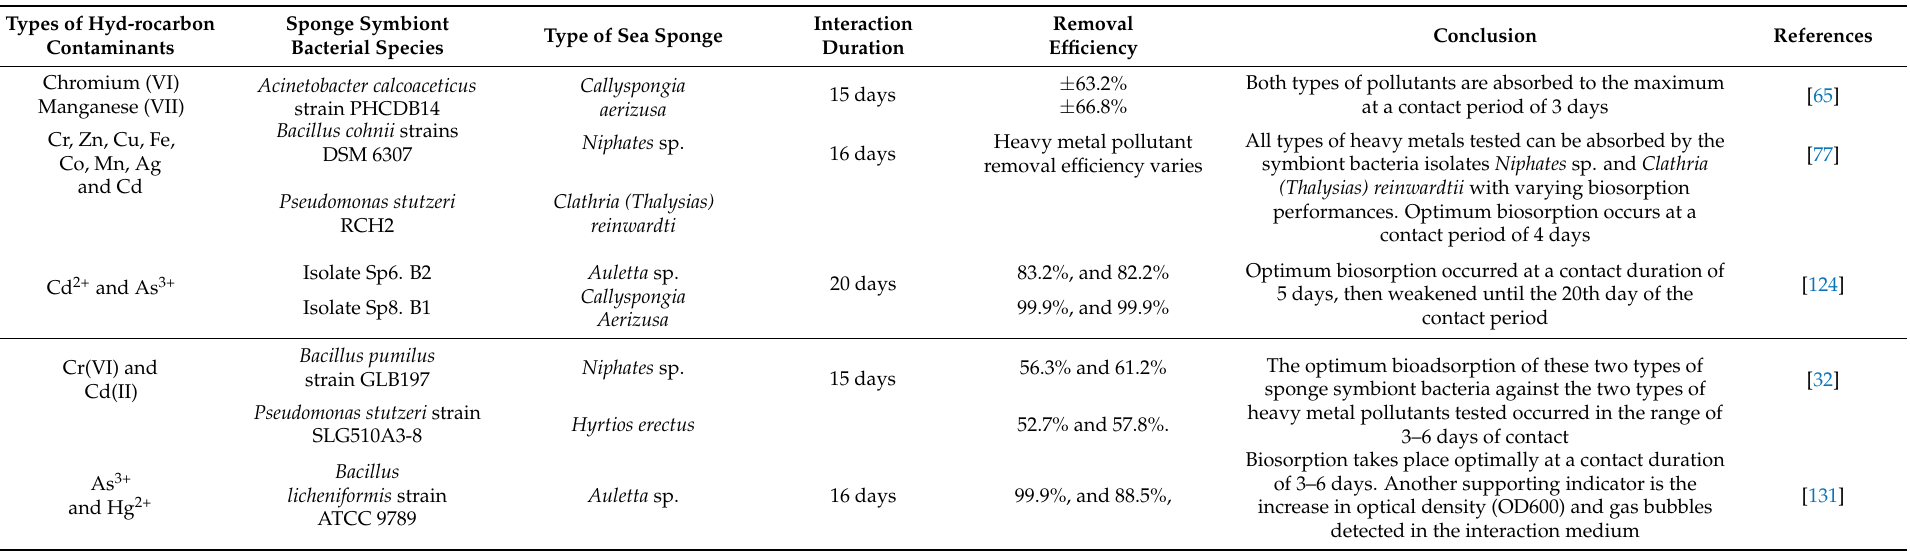
Table 3. Various studies on the bio-adsorption performance of sponge symbiont bacteria against heavy metal